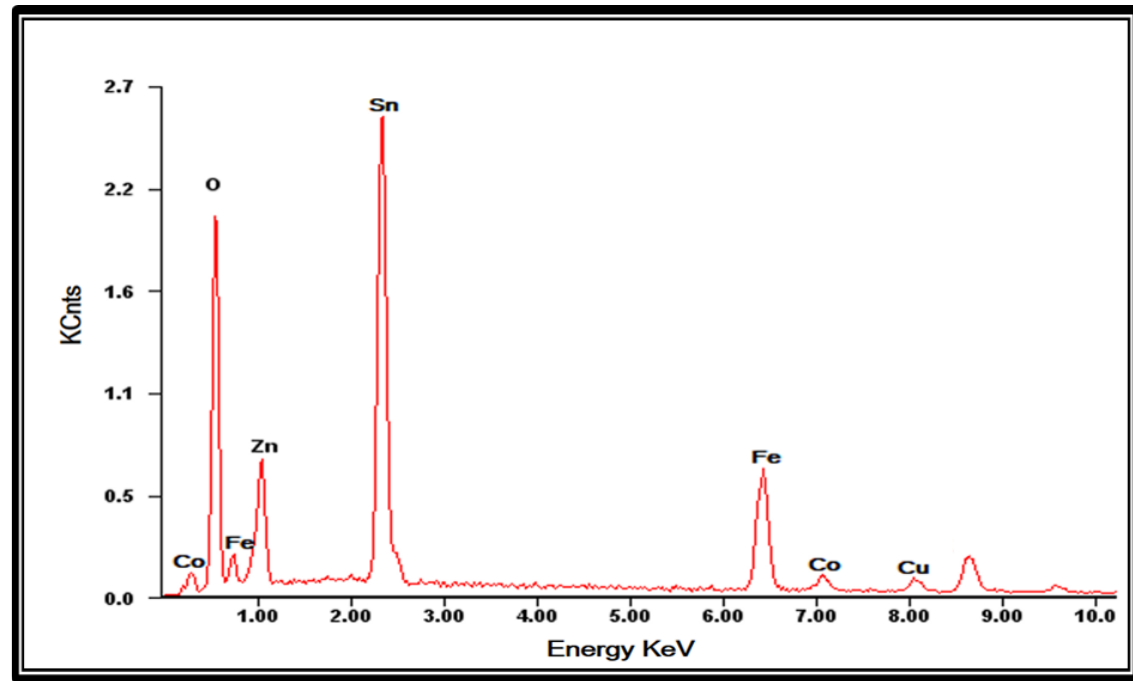
Figure 4. EDX image of Co-Cu-Zn-Fe oxides-based deposited films in basic medium at −1.5. Table 2. wt.% and at.% of tetra-metallic thin film coated on FTO. Element